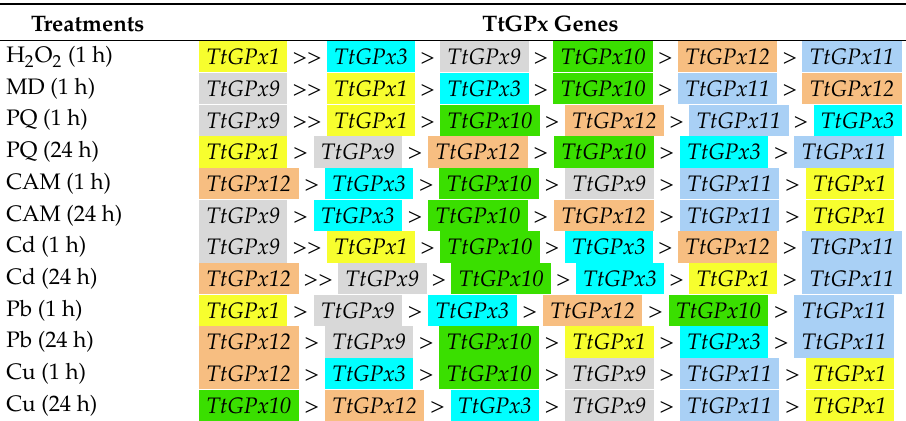
Table 3. Ranking of gene expression induction